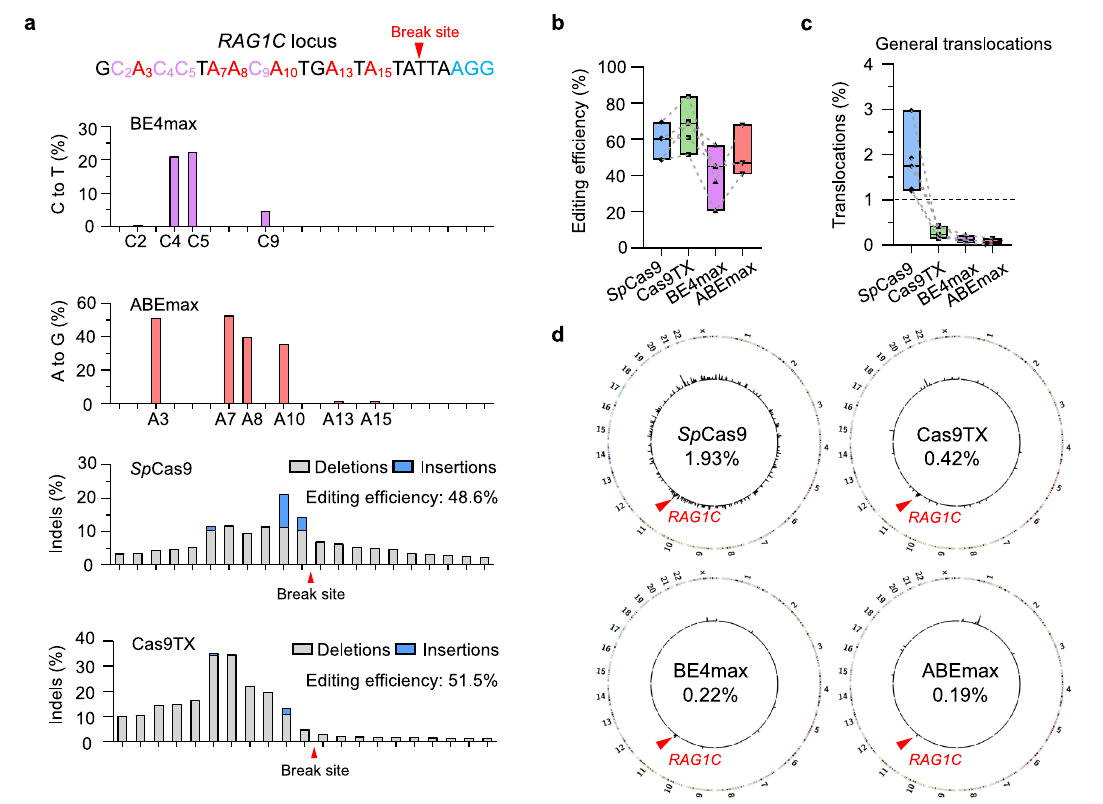
Fig. 5 Suppressing chromosomal translocations down to the level of base editors by Cas9TX. a Editing patterns around the break site for BE4max, ABEmax, Sp Cas9, and Cas9TX at the RAG1C locus detected by PEM-seq. Red arrows indicate the presumed break sites. Accumulative levels of mutations, deletions, and insertions are shown at nucleotide resolution. b , c Editing ef fi ciency ( b ) and the percentages of general translocations ( c ) for Sp Cas9, Cas9TX, BE4max, and ABEmax detected by PEM-seq at EMX1 , C-MYC2 , DNMT1-2 , RAG1C , and BCL11A in HEK293T cells. One independent PEM-seq library for each locus, N = 5. Of note, the EMX1 and C-MYC2 sites were not targetable by ABEmax. Values from minimum to maximum are shown in the box. The line represents the median. d Circos plot showing the distribution of translocations for Sp Cas9, Cas9TX, BE4max, and ABEmax at RAG1C in HEK293T cells. Red arrows indicate the RAG1C target site. The percentages of general translocations are shown in the